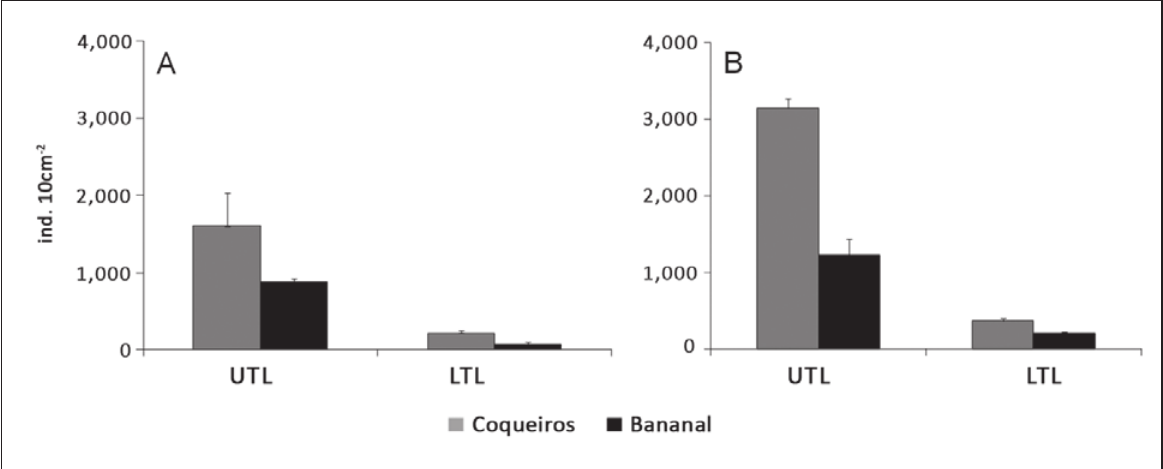
Fig. 2 - Mean density (ind.10cm -2 ± standard error) of nematodes at the two tide levels on the two beaches investigated. A: January, B: June. UTL: upper tide level, LTL: low tide level.